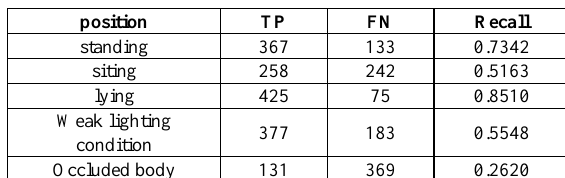
Table 4. Performance of SRHOG in different